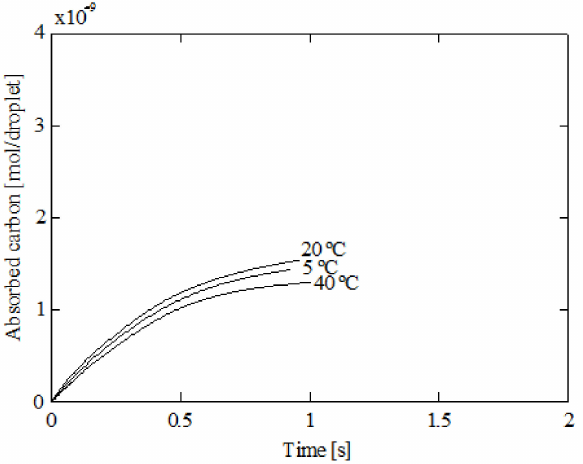
Figure 16. Absorbed carbon by a droplet for several initial liquid temperatures; 5% initial ammonia concentration, 100 ◦ C initial gas temperature, and 1000 µ m initial